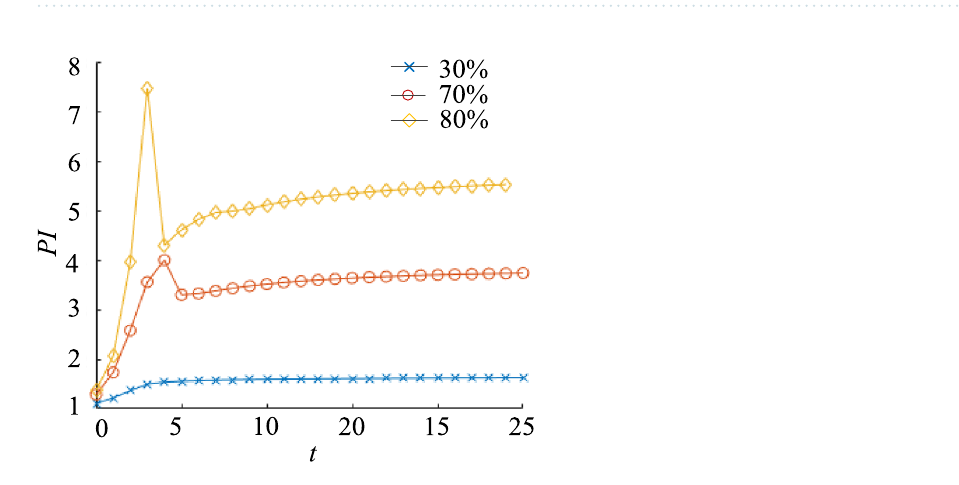
Figure 15. The performance index history curves under different material removal ratio